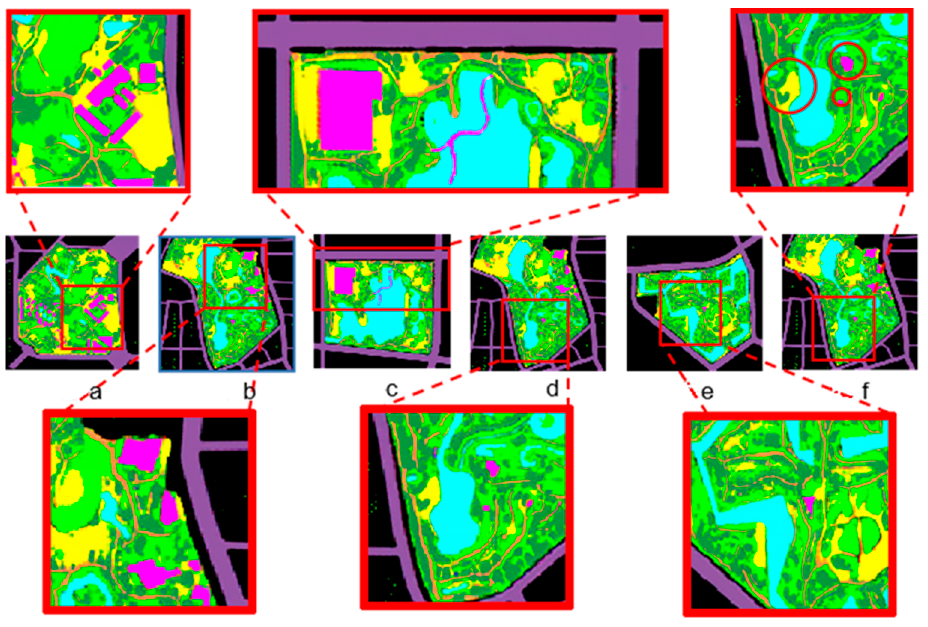
Figure 15. Analysis of elemental location relationships.